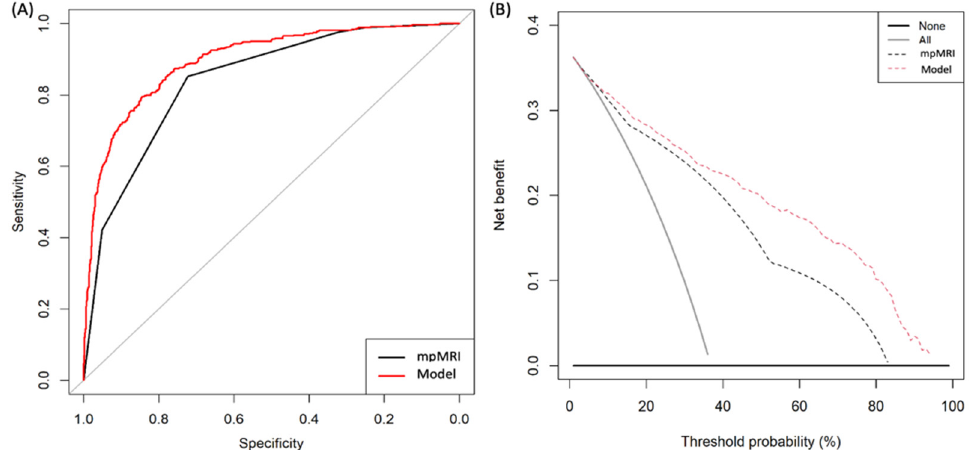
Figure 2. ROC curves showing the efficiency of MRI and MRI-PM in the development cohort ( A ). DCAs evaluating the net benefit of MRI and MRI-PM over biopsying all men belonging to the development cohort ( B ).